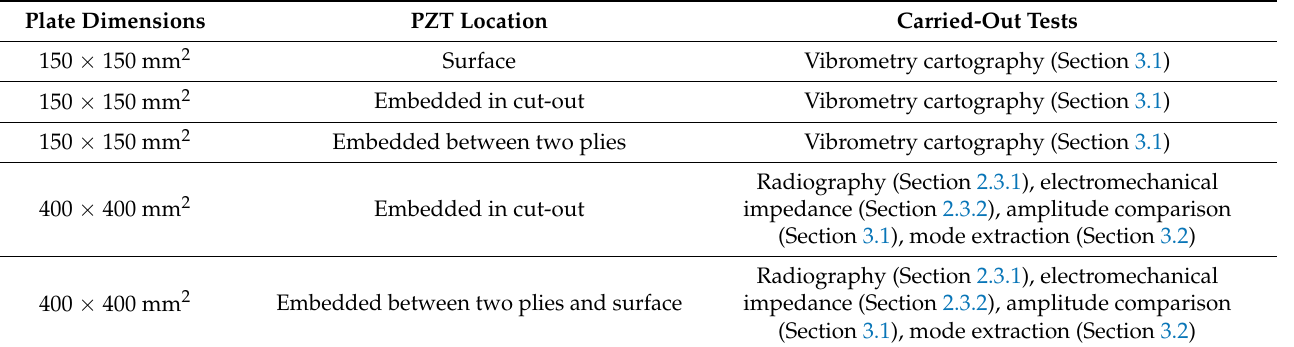
Table 1. Manufactured plates and carried-out tests.